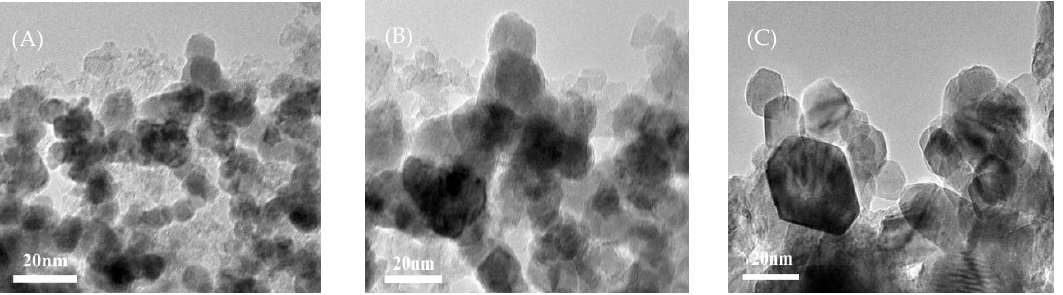
Figure 3. Transmission electron microscopy (TEM) images of the CuO-Bi 2 O 3 catalysts. ( A ) CB-500, ( B ) CB-600, and ( C ) CB-700.